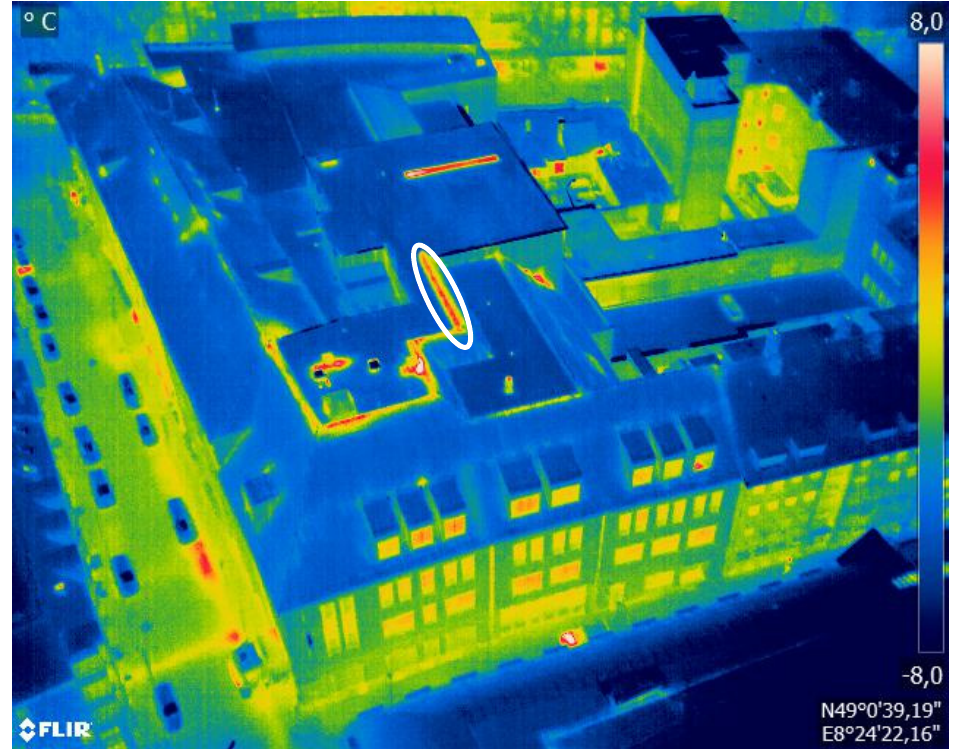
Figure A23. Example: thermal bridge of a roof ridge.